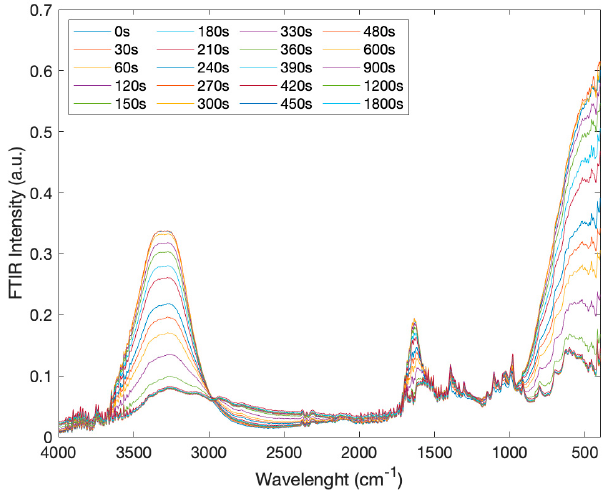
Figure 1. IR Spectra of creatine aqueous solutions as a function of time (range: 0 ÷ 1800 s) in the spectral range 4000–400 cm − 1 .